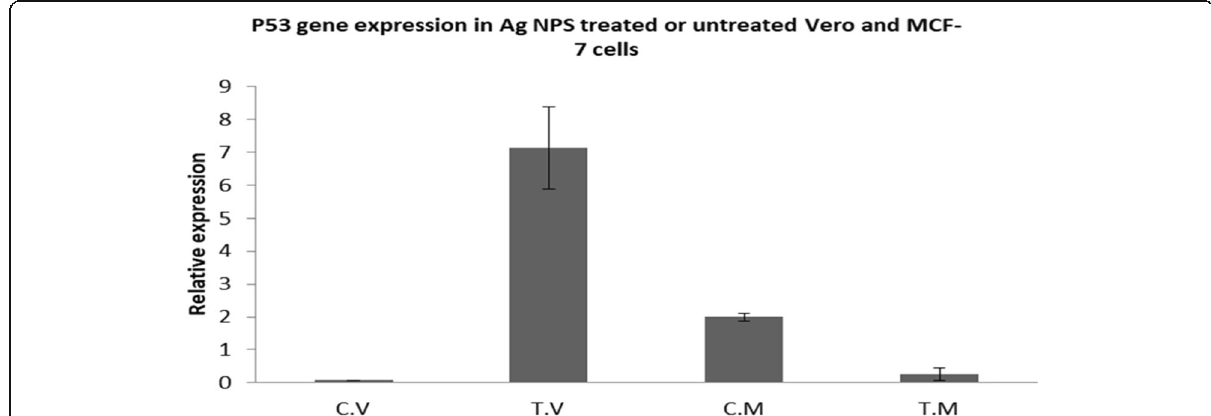
Fig. 7 P53 relative expression in MCF-7 and Vero cell treated or untreated with Ag NPs. Total RNA was extracted, reverse transcribed, and the synthesized DNA was used as a template for qPCR relative expression assay using SYBR green master mix. Data were analyzed by ΔΔ CTs and normalized to ( β -actin) house-keeping gene ( t test P < 0.058, 0.007)